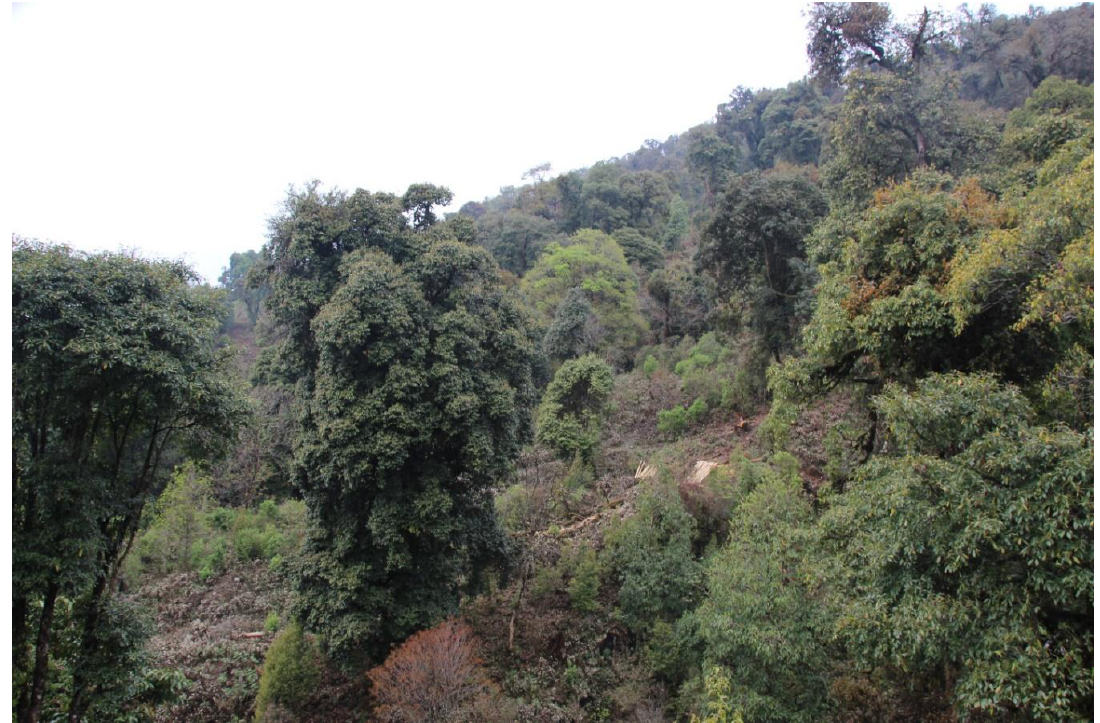
Figure 3. Forest after the extraction of timber at Khaling-Kharungla Forest Management Unit, Trashigang Dzongkhag Bhutan. (Photo credit: Jigme Wangchuk).